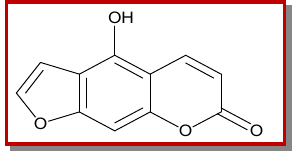
Figure 1: The chemical structure of